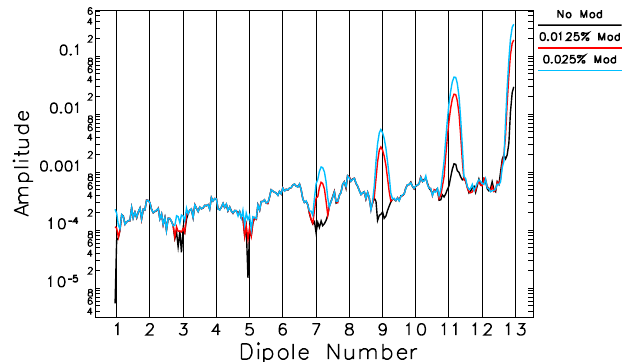
FIG. 12. (Color) Evolution of the modulation amplitude in FERMI as a function of location in the dipoles of the chicanes, for three cases: no initial modulation, 0.0125% initial modula- tion at 25 (cid:1) m , and 0.025% initial modulation at 25 (cid:1) m . Dipole 1 is the first dipole in the first chicane, dipole 4 is the first dipole in the second chicane, and so on. Linac structures exist between dipoles 4 and 5, and between dipoles 8 and 9.